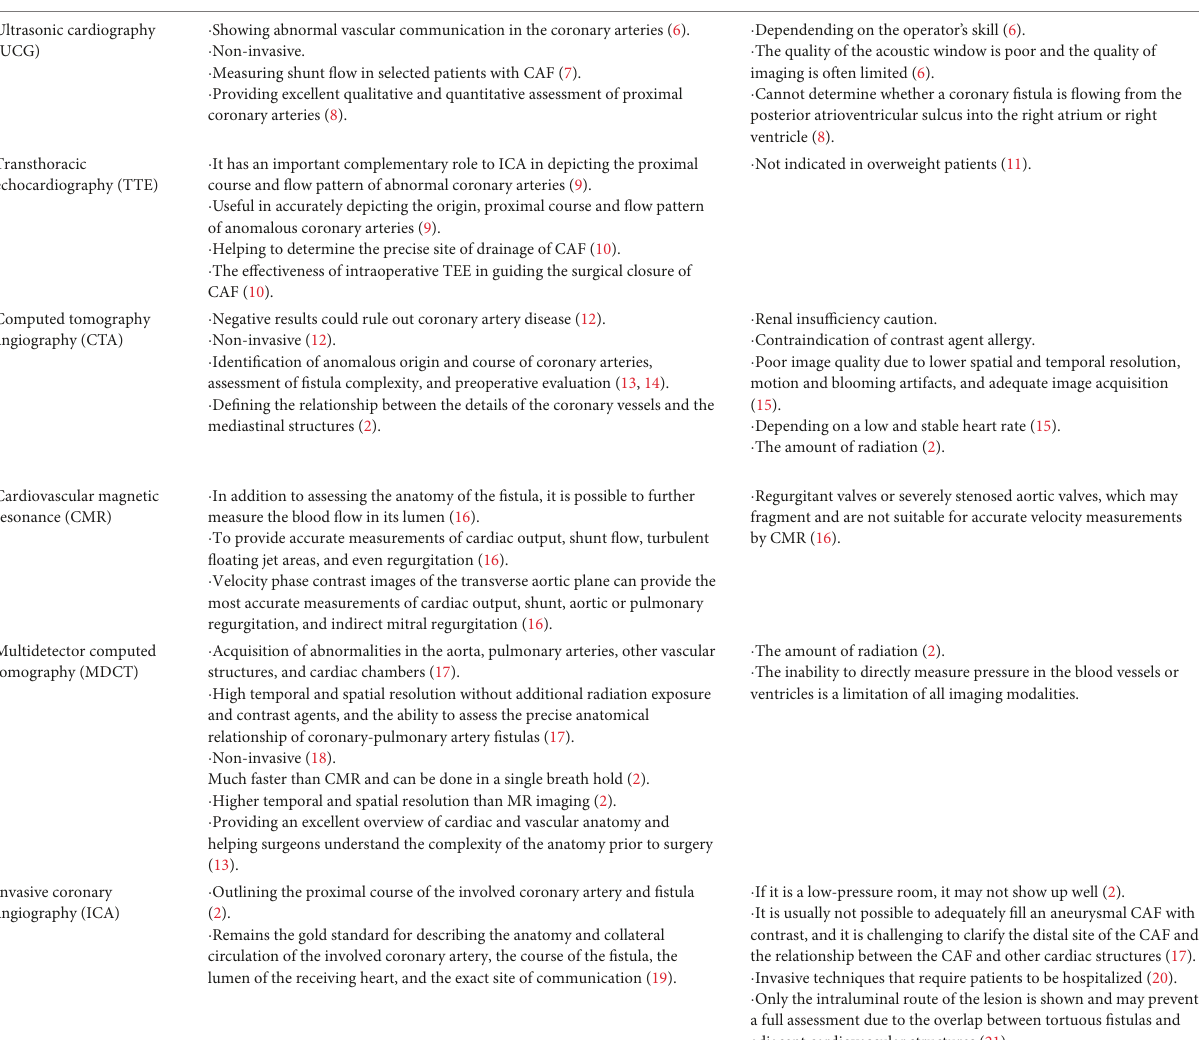
TABLE 2 The main diagnostic methods of